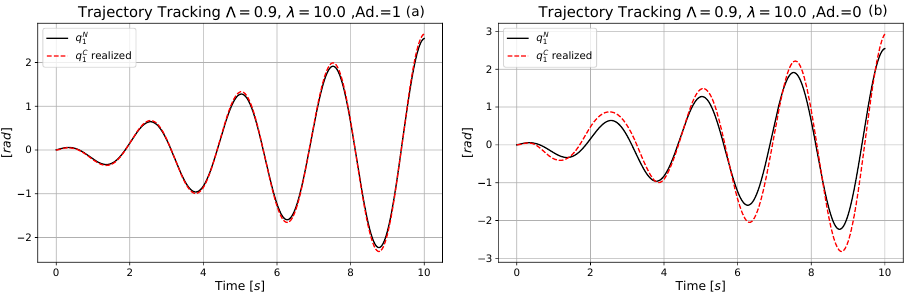
Figure 19. The trajectory tracking. ( a ): Adaptive. ( b ): Non-adaptive.